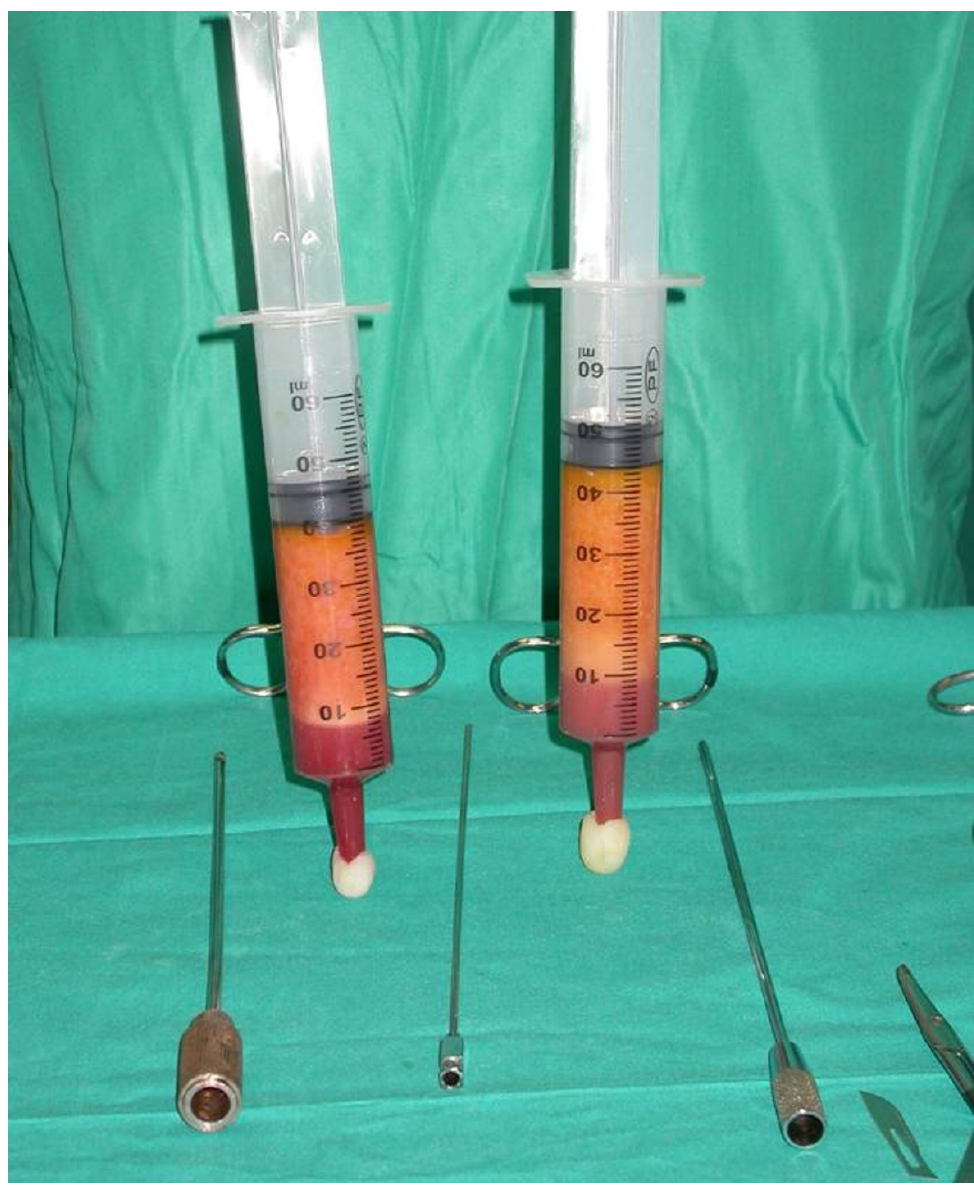
Figure 2. The harvested fat is drained by gravity.